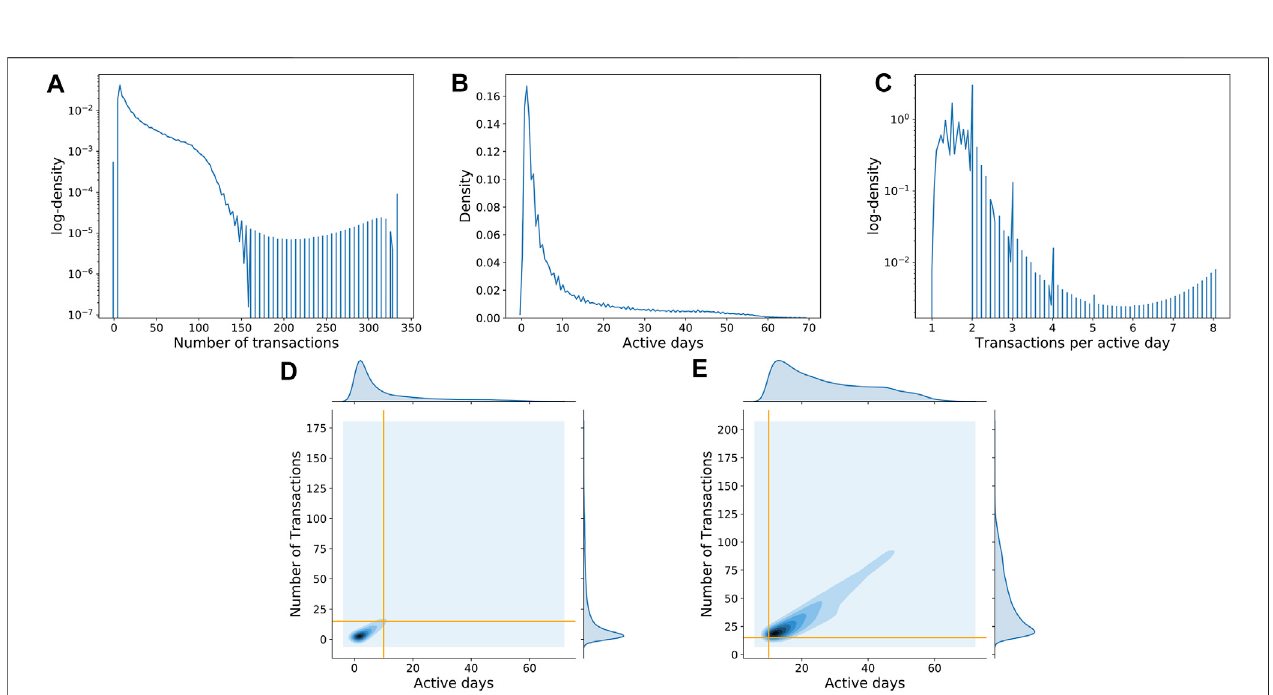
FIGURE 2 | Transit travel sequence distributions. (A) Distribution of the number of transactions. (B) Distribution number of active days. (C) Distribution of the numberoftransactionsperactiveday. (D) non- fi lteredjointdistributionnumberoftransactionandactivedays. (E) Filterjointdistributionnumberoftransactionandactive days. Orange line represent the cutoff fi lter points at 10 active days, and 15